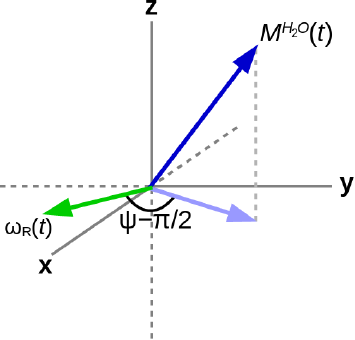
Figure 1. The RD field ω R ( t ) (green arrow) lies in the xy plane. It has an amplitude that is proportional to the projection (light-blue arrow) of the water magnetization M H 2 O ( t ) (dark-blue arrow) onto the same plane and a phase of ψ − π/ 2 with respect to this projec- tion.